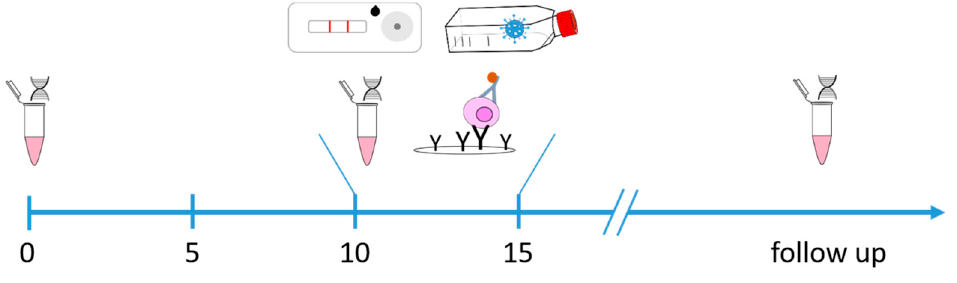
Figure 1. Study design. 79 patients were enrolled in the study; all of them had positive SARS-CoV-2 RT-PCR and were unvaccinated against SARS-CoV-2. Blood was drawn and nasopharyngeal swabs were taken approximately 10–15 days later to perform an antigen test, virus cultivation, an ELISpot assay and SARS-CoV-2 RT-PCR. Given the fact that the second SARS-CoV-2 PCR was positive, a follow-up PCR was performed around 7 days